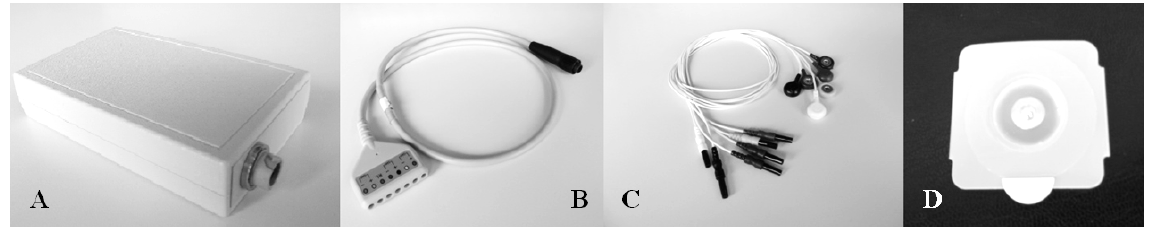
Figure 1. Wearable components of the ECG/ICG/acceleration cardiographic system. ( A